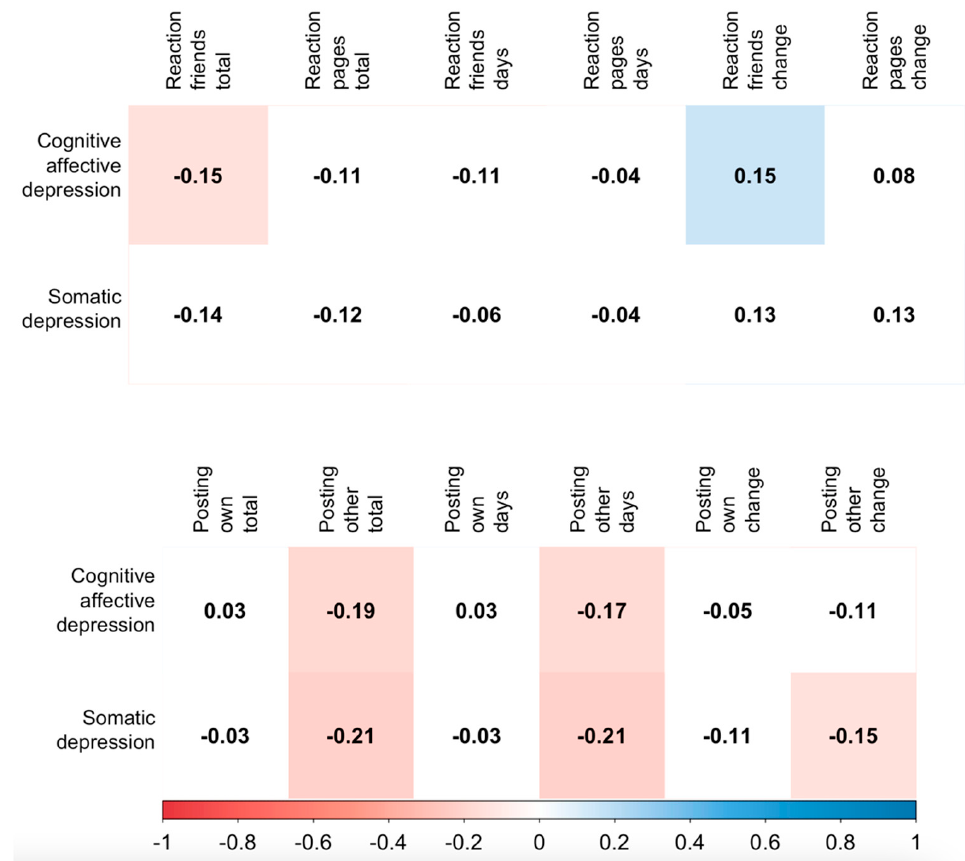
Figure 4. Pearson correlation between activity indicators and depression